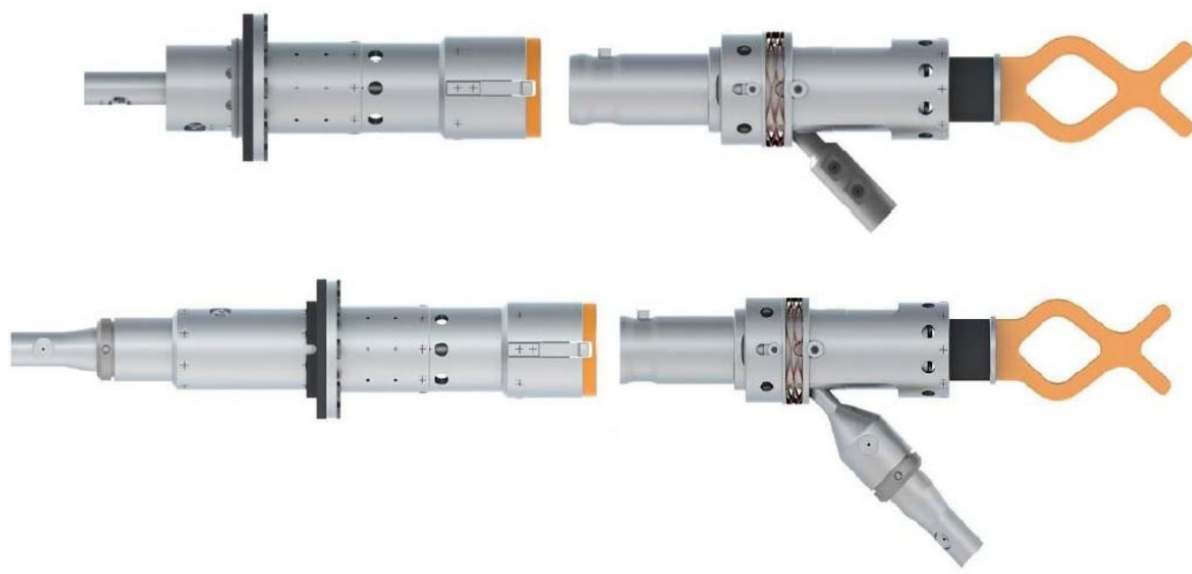
Figure 2. The SEACON HydraLight Optical WMC and the High Capacity Optical WMC [28].